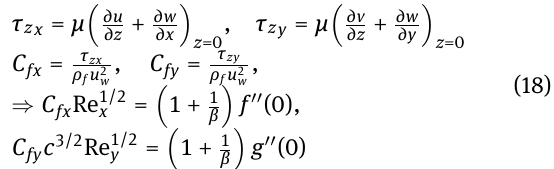
Fig. 2: Influence of β on f (cid:48) ( η )